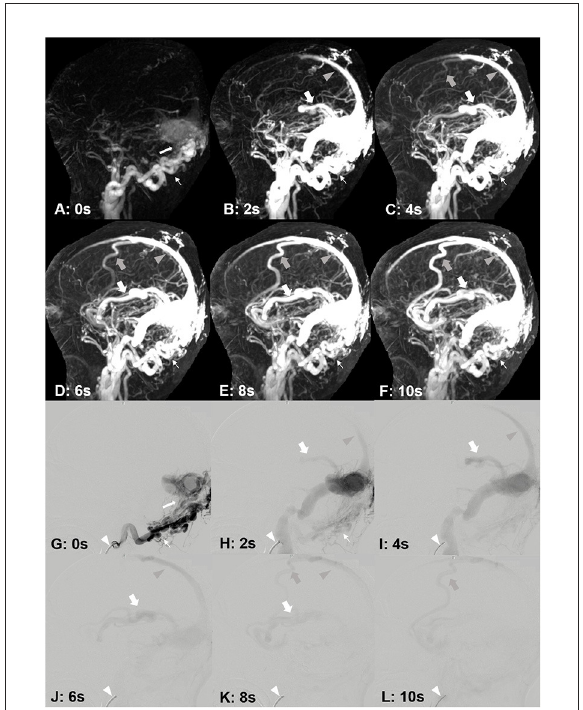
FIGURE6 A 33-year-old male, suffered from right tinnitus for 1 year and left headache, dizziness and memory decrease for 1 month. DAVF was identified by DISCO-MRA (A–F) . The occipital artery feeding [ (A–F) , narrow arrows] DAVF occurred in the lateral sinus [ (A) , white arrow], and the reflux was found in the superior sagittal sinus [ (B–F), gray arrow heads], cortical vein [ (C–F) , gray bold arrows) and Labbe’s vein [ (B–F) , bold arrows]. The interval time of each frame is 2s. DAVF was confirmed by DSA (G–L) . The catheter [ (G–L) , white arrow head] was placed in right occipital artery [ (G,H) , narrow arrows]. The fistula occurred in the lateral sinus [ (G) , white arrow], and the reflux was found in the superior sagittal sinus [ (H–K) , gray arrow heads], cortical vein [ (K,L) , gray bold arrows] and Labbe’s vein [ (H–K) , bold arrows]. The interval time of each frame is 2s.